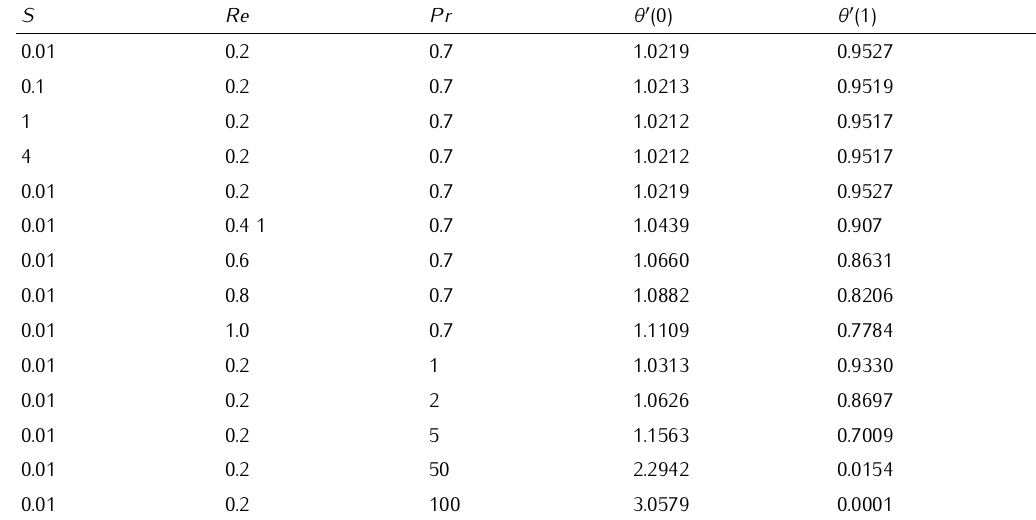
Table 1. Effect of Permeability parameter ( S ) , Reynolds number ( Re ) , Prandtl number ( Pr ) on heat transfer coefficients.